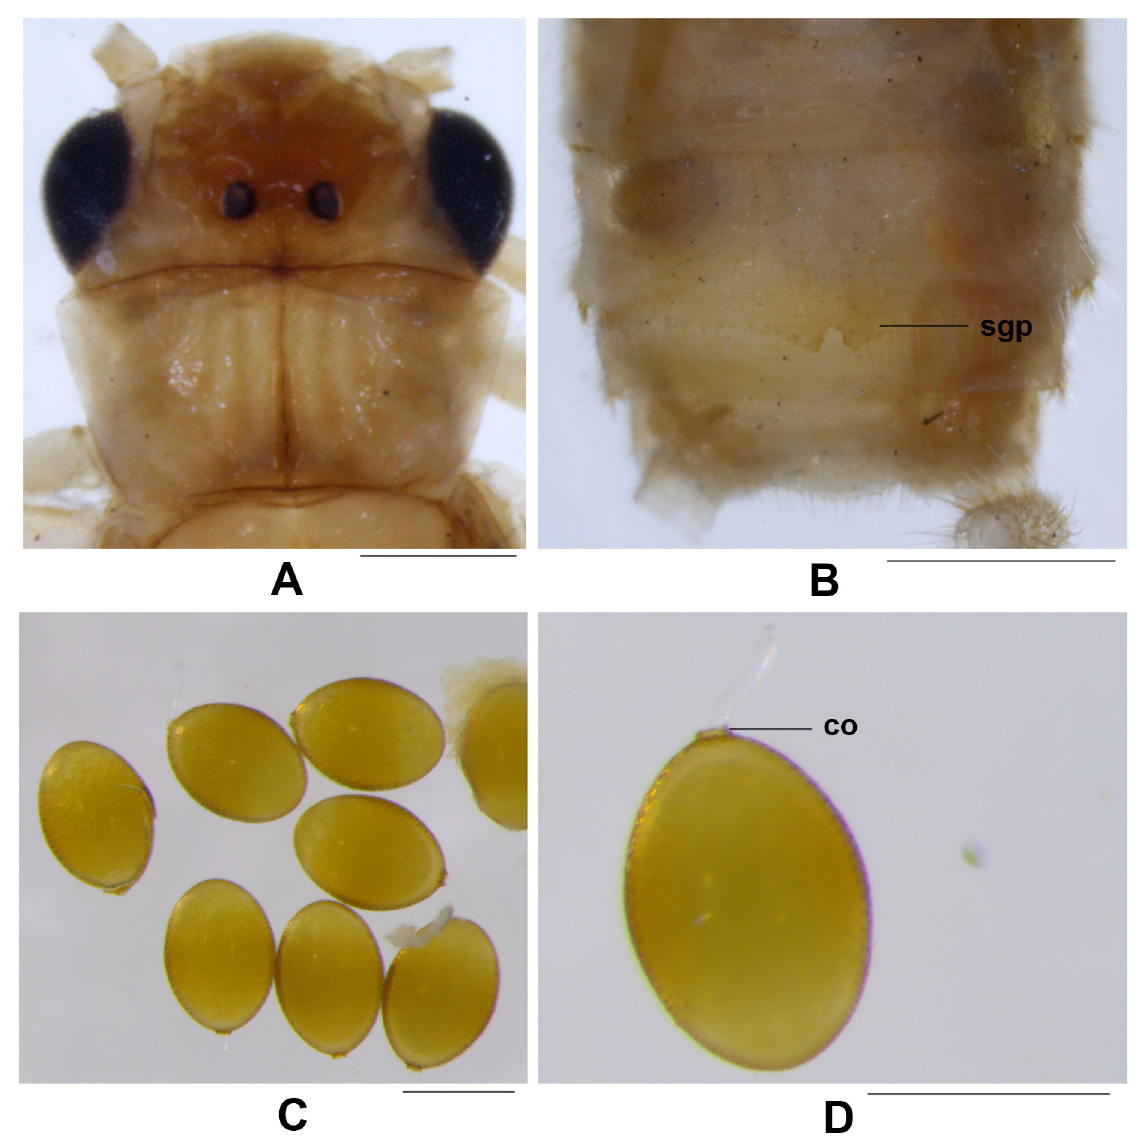
Fig. 4. Chinoperla changjiangensis sp. nov., ♀, paratype (CAU) A . Head and pronotum, dorsal view. B . Terminalia, ventral view. C . Eggs, lateral view. D . Entire egg, lateral view. Abbreviations: see Material and methods. Scale bars: A–B = 0.5 mm; C–D = 0.2